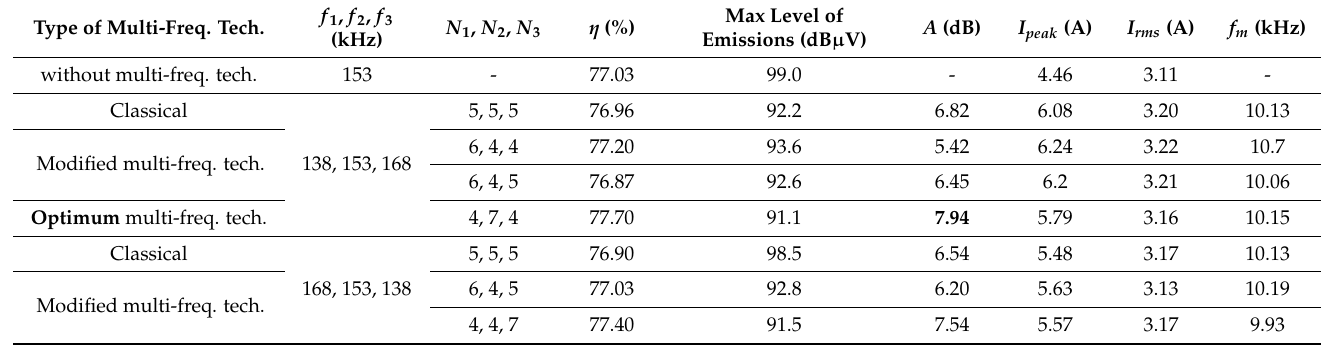
Table 4. The performance characteristics of the wireless battery charger without the multi-switching- frequency technique and with the technique (with different combinations of a number of pulses and the order of the switching frequencies). The load resistance is 18 Ω , and the lateral misalignment is 1